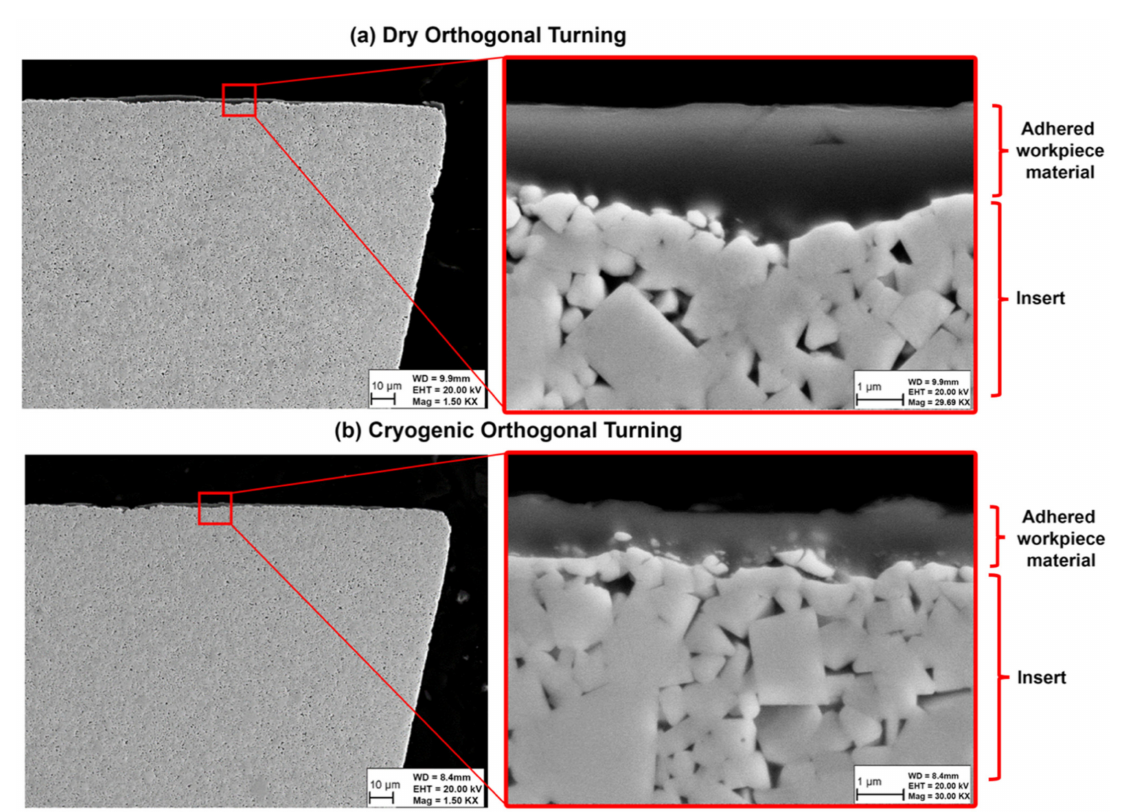
Figure 14. SEM images for the cross-sections of the ( a ) dry and ( b ) cryogenic cutting inserts.